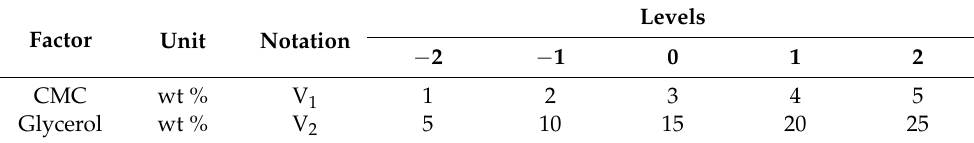
Table 1. Factors and levels.